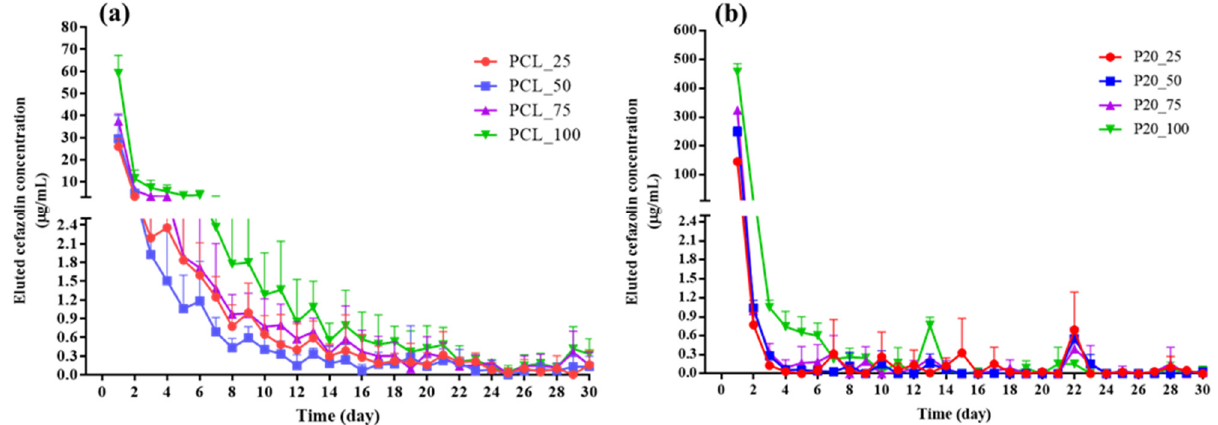
Figure 4. Cefazoline release profile of cefazolin loaded samples in aCSF solution: ( a ) Cefazolin loaded PCL; ( b ) cefazolin loaded ORC/PCL bilayered composites. Data are expressed as mean ± standard deviation (SD).